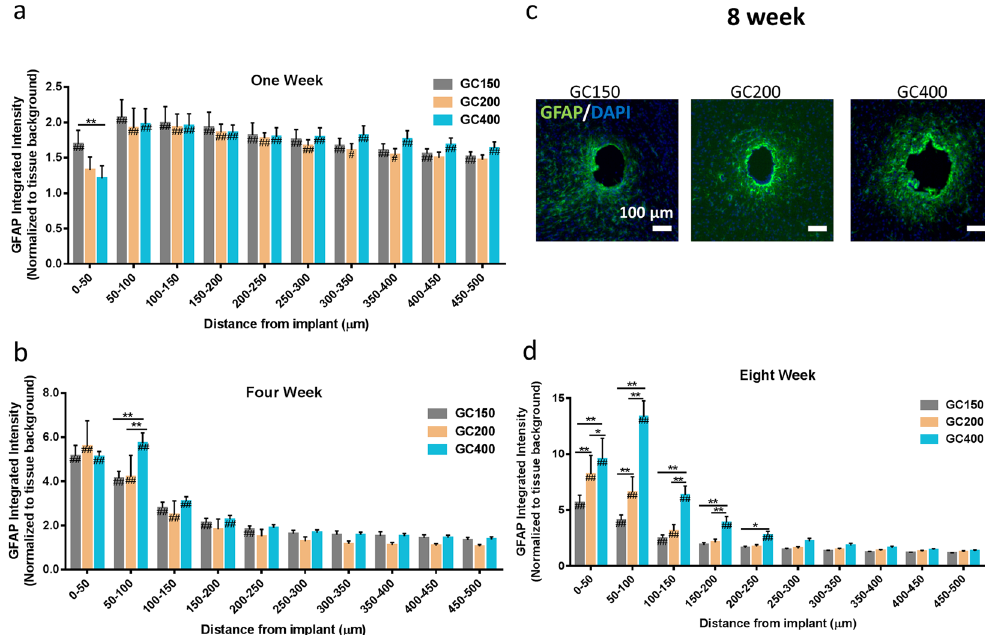
Figure 5. Increasing implant diameter has additional effects on the biological response at 8 weeks post implantation. ( a ) Representative IF images of the IgG and ED1 reactivity around implants at 8 weeks post implantation (scale bar 100 μ m). ( b ) Representative IF images of the NeuN staining around glass capillary implants at 8 weeks post implantation. (Scale bar 100 μ m). ( c , d , e ) IgG, NeuN, and ED1 staining around the implants at eight weeks post implantation. Animals with increased diameter implants were found to have increased BBB permeability, IgG ( d ) decreased neural density, and ( e ) increased activated macrophages staining in the region directly surrounding the implant location. ** p < 0.01, * p < 0.05 indicates a statistically significant